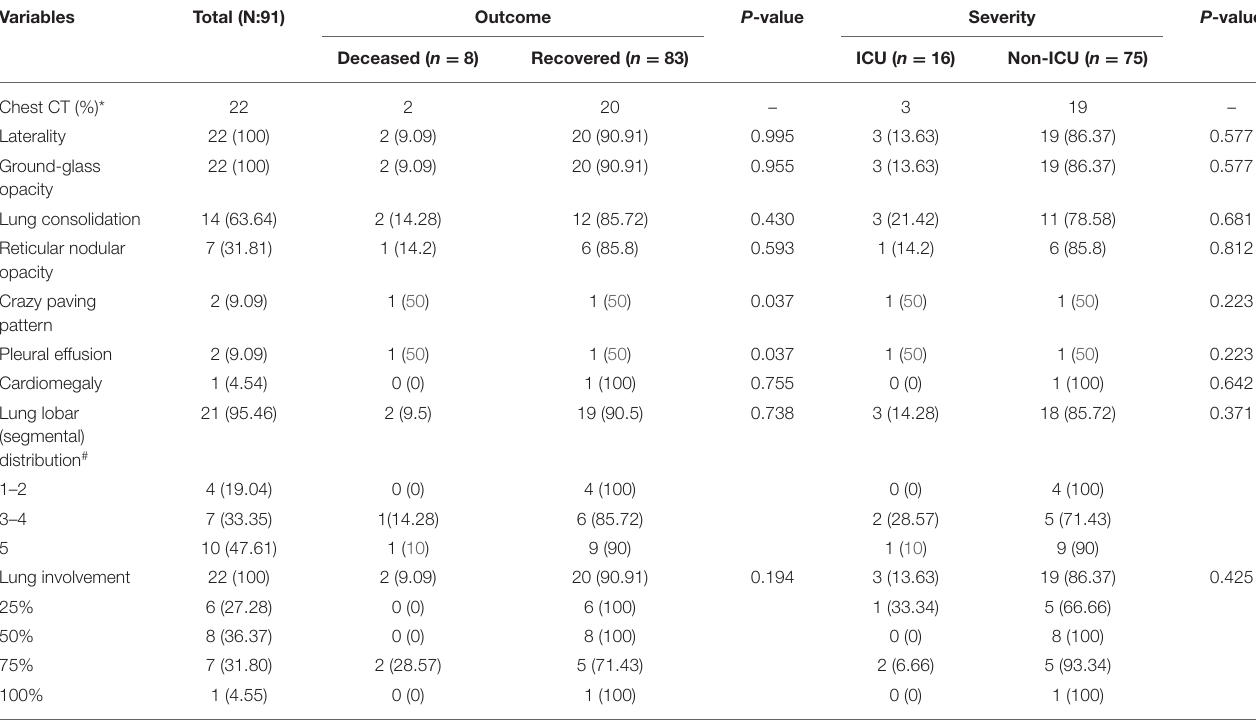
TABLE 4 | Radiological findings of pediatric COVID-19